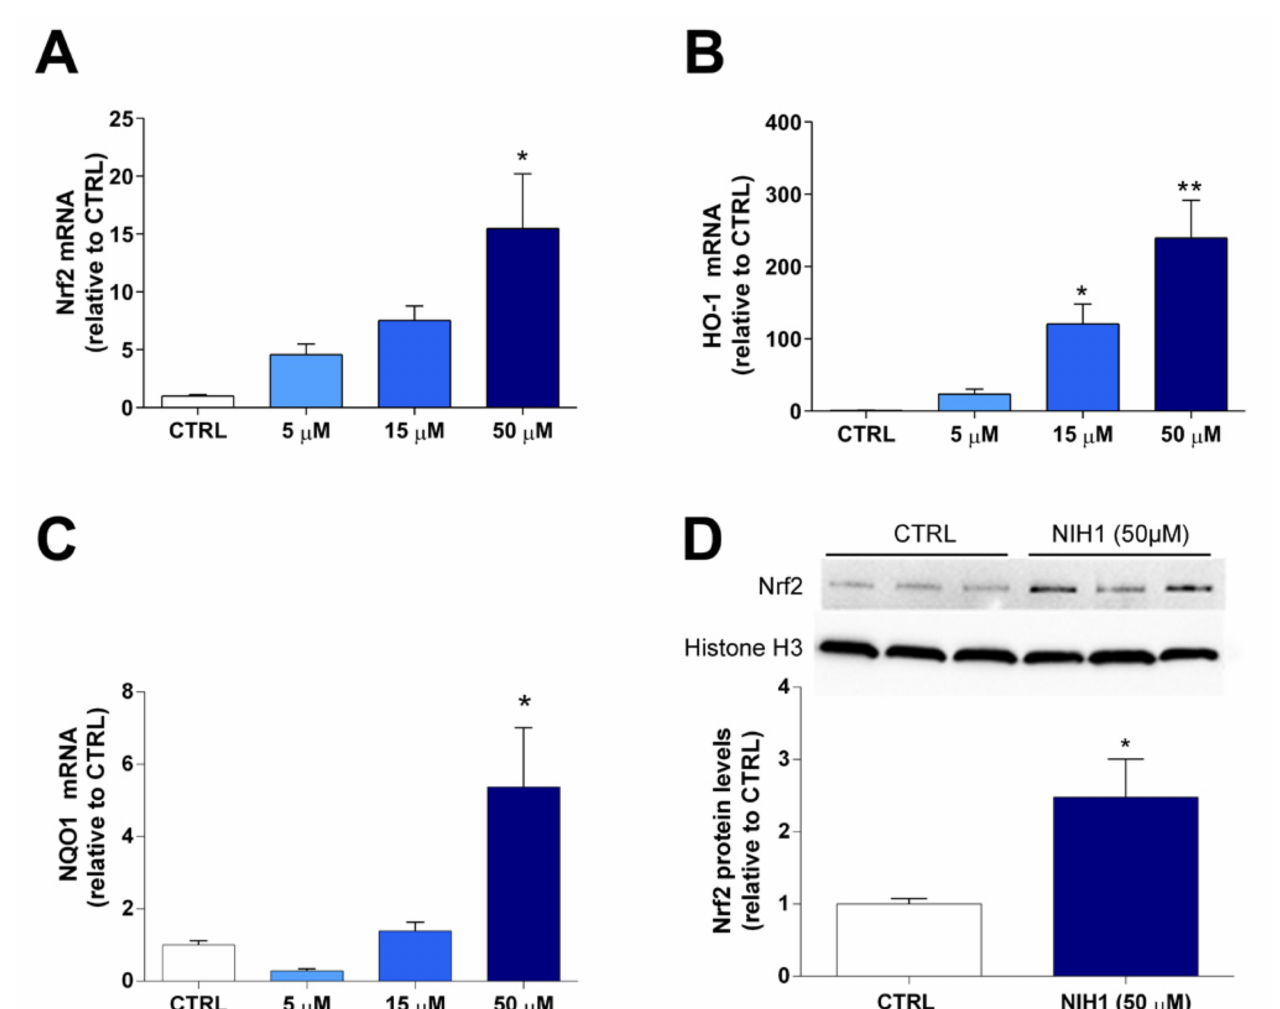
Figure 2. Dose-response analysis of mRNA expression and Nrf2 nuclear translocation in retinal explants treated with NIH1. The mRNA levels of Nrf2 ( A ), HO-1 ( B ), and NQO-1 ( C ) were evaluated with qPCR in control retinal explants (CTRL) or in retinal explants treated with 5, 15, or 50 µ M NIH1 for 24 h. One-way ANOVA followed by the Newman-Keuls multiple comparison post-hoc test ( n = 3; * p < 0.05, ** p < 0.01 vs. CTRL). ( D ) Western blot analysis of nuclear protein fraction showing representative immunoreactive bands and quantitative densitometric analysis of the Nrf2 protein levels in CTRL explants and in explants treated with 50 µ M NIH1 for 24 h. Unpaired t- test, n = 3; * p < 0.05, ** p < 0.01 vs